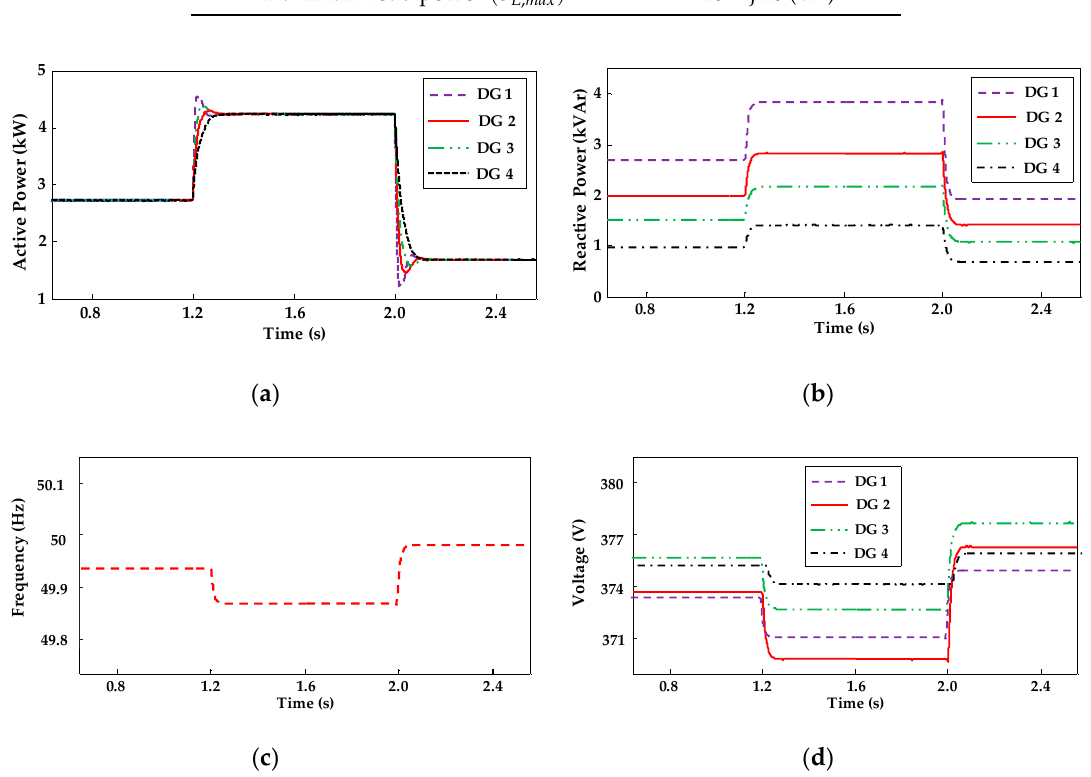
Figure 5. Scenario with conventional droop controller: ( a ) active power sharing; ( b ) reactive power sharing; ( c ) system frequency; ( d ) distributed generation (DGs) terminal voltages.